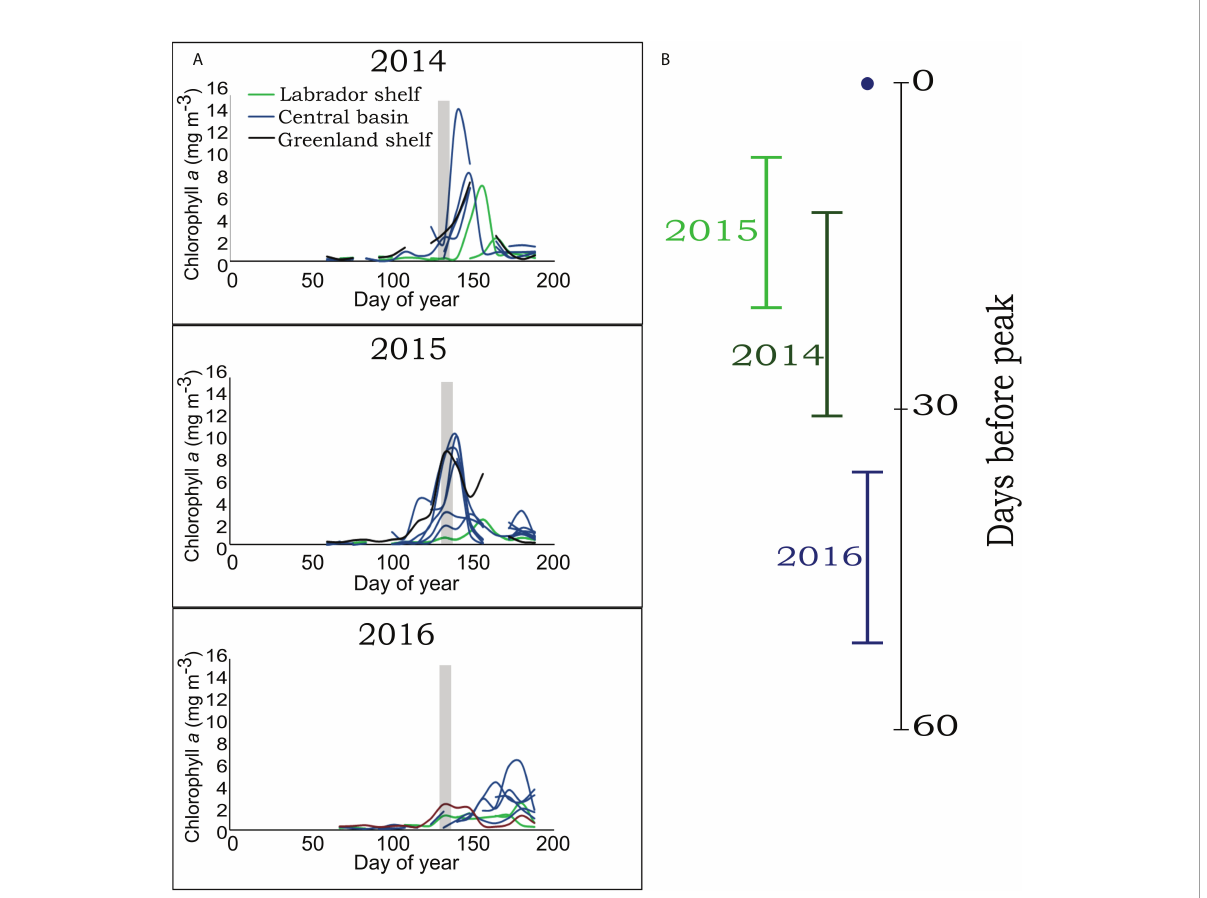
FIGURE 2 Chlorophyll- a concentrations (mg m -3 ) from satellite observations between days of year 60 and 188 for 2014, 2015, 2016 (A) . Each line represents a sampling station with colors corresponding to water masses. The grey area represents the sampling period. Number of days before peak chlorophyll- a for all stations grouped by year (B)